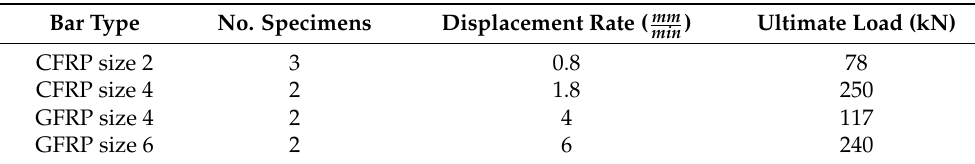
Table 2. FRP tensile test load information. The displacement rate is calculated based on the CAN/CSA-S806-12 code for FRP bars.